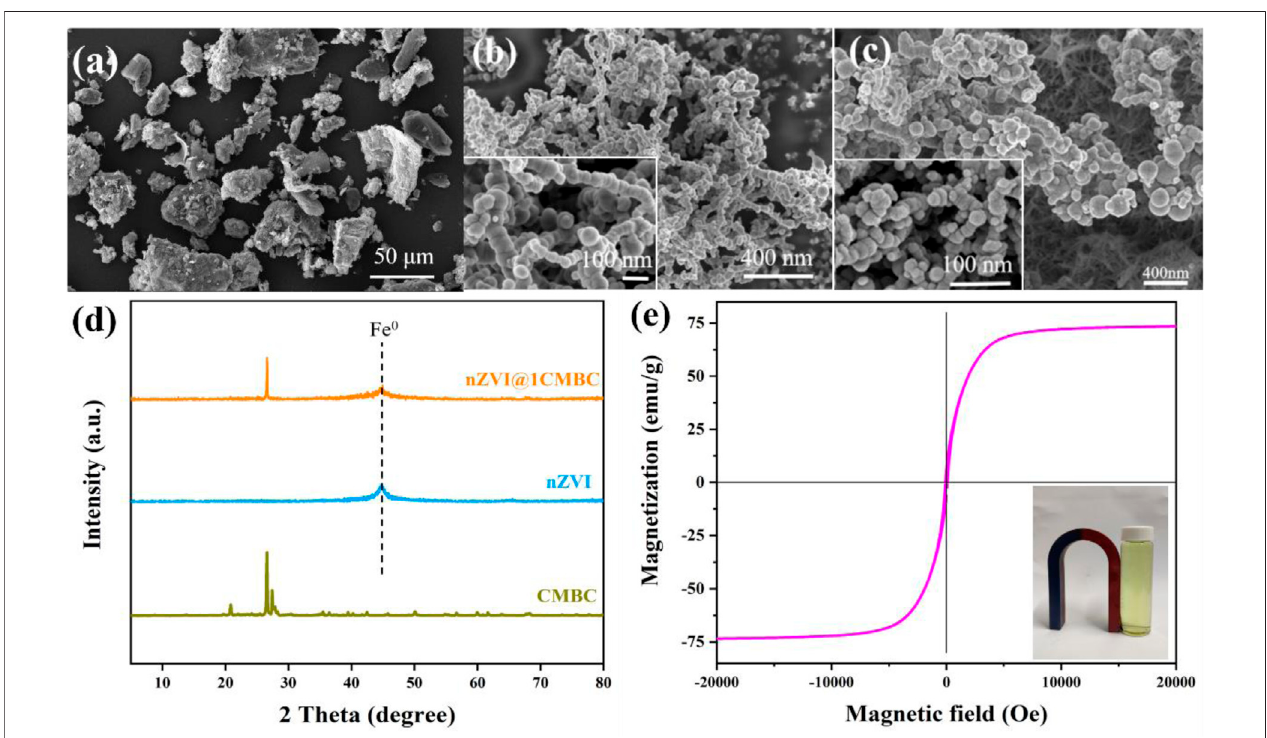
FIGURE1| SEMimagesofCMBC (A) ,nZVI (B) ,andnZVI@1CMBC (C) ;XRDpatternsofnZVI,CMBC,nZVI@1CMBCandCr(VI)-nZVI@1CMBC (D) ,andmagnetic hysteresis loops of nZVI@1CMBC (E)